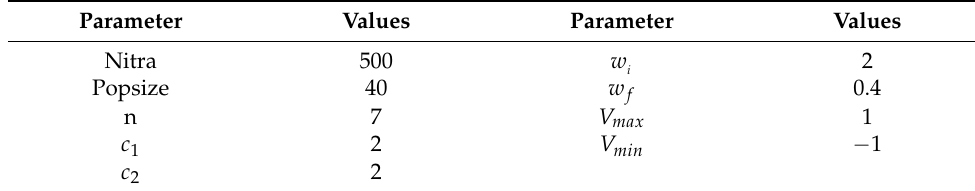
Table 3. BPSO algorithm parameters